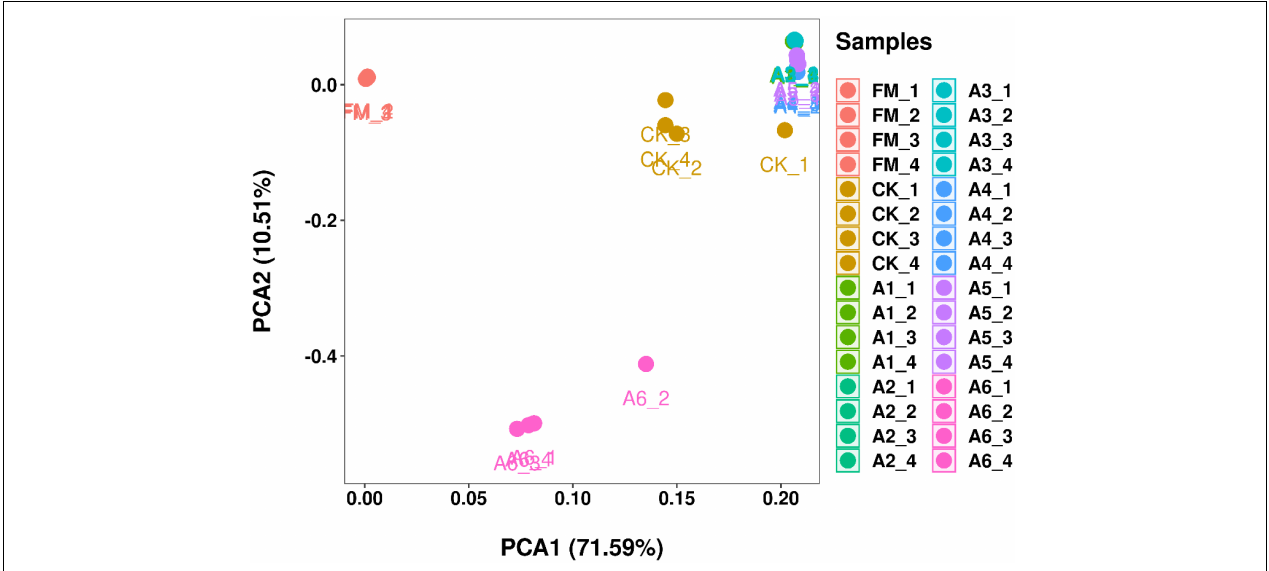
FIGURE 1 | Principal component analysis (PCA) of the bacterial communities in silage and fresh materials ( n = 4). FM, fresh materials; CK (Control), 2.00 ml/kg fresh weight (FW) of distilled water; A1, 2 g/t FW of the first additive and 2.00 ml/kg FW of distilled water; A2, 2 g/t FW of the second additive and 2.00 ml/kg FW of distilled water; A3, 5 g/t FW of the third additive and 2.00 ml/kg FW of distilled water; A4, 1 g/t FW of the fourth additive and 2.00 ml/kg FW of distilled water; A5, 1 g/t FW of the fifth additive and 2.00 ml/kg FW of distilled water; A6, 1 g/t FW of the sixth additive and 2.00 ml/kg FW of distilled water.